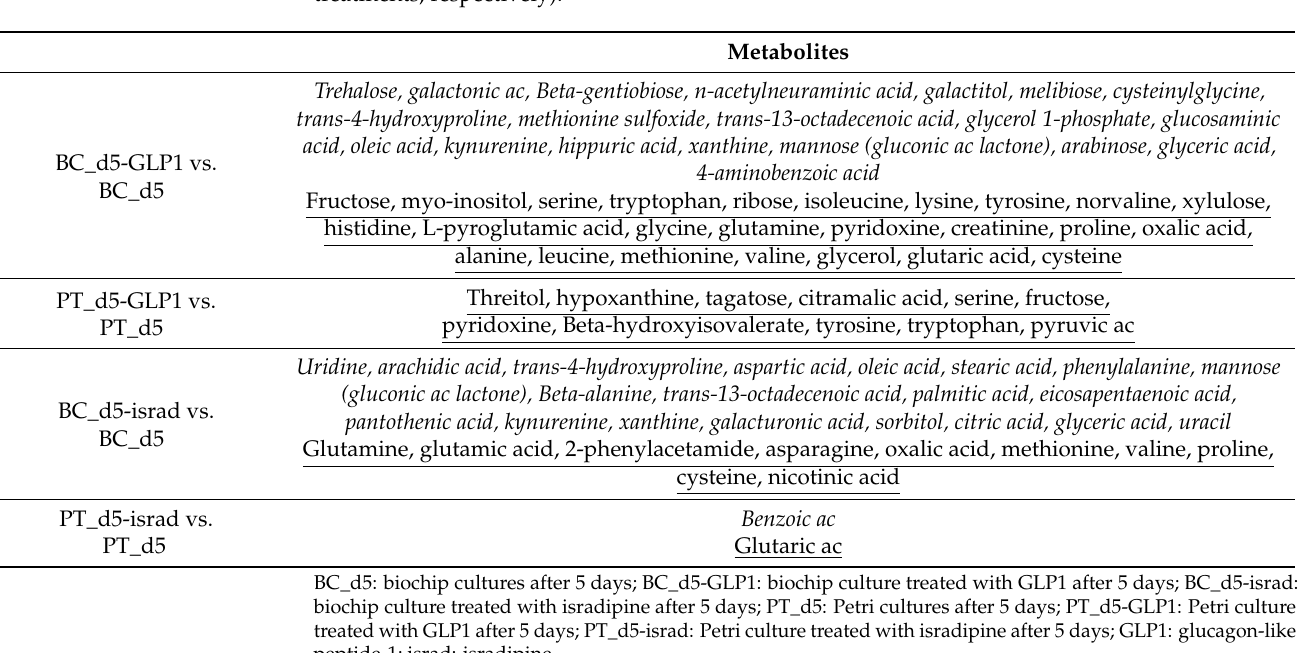
Table 1. Metabolites significantly modulated by GLP1 and isradipine in Petri and biochip cultures (underline and italics denote metabolites upregulated and downregulated by GLP1 and isradipine treatments,